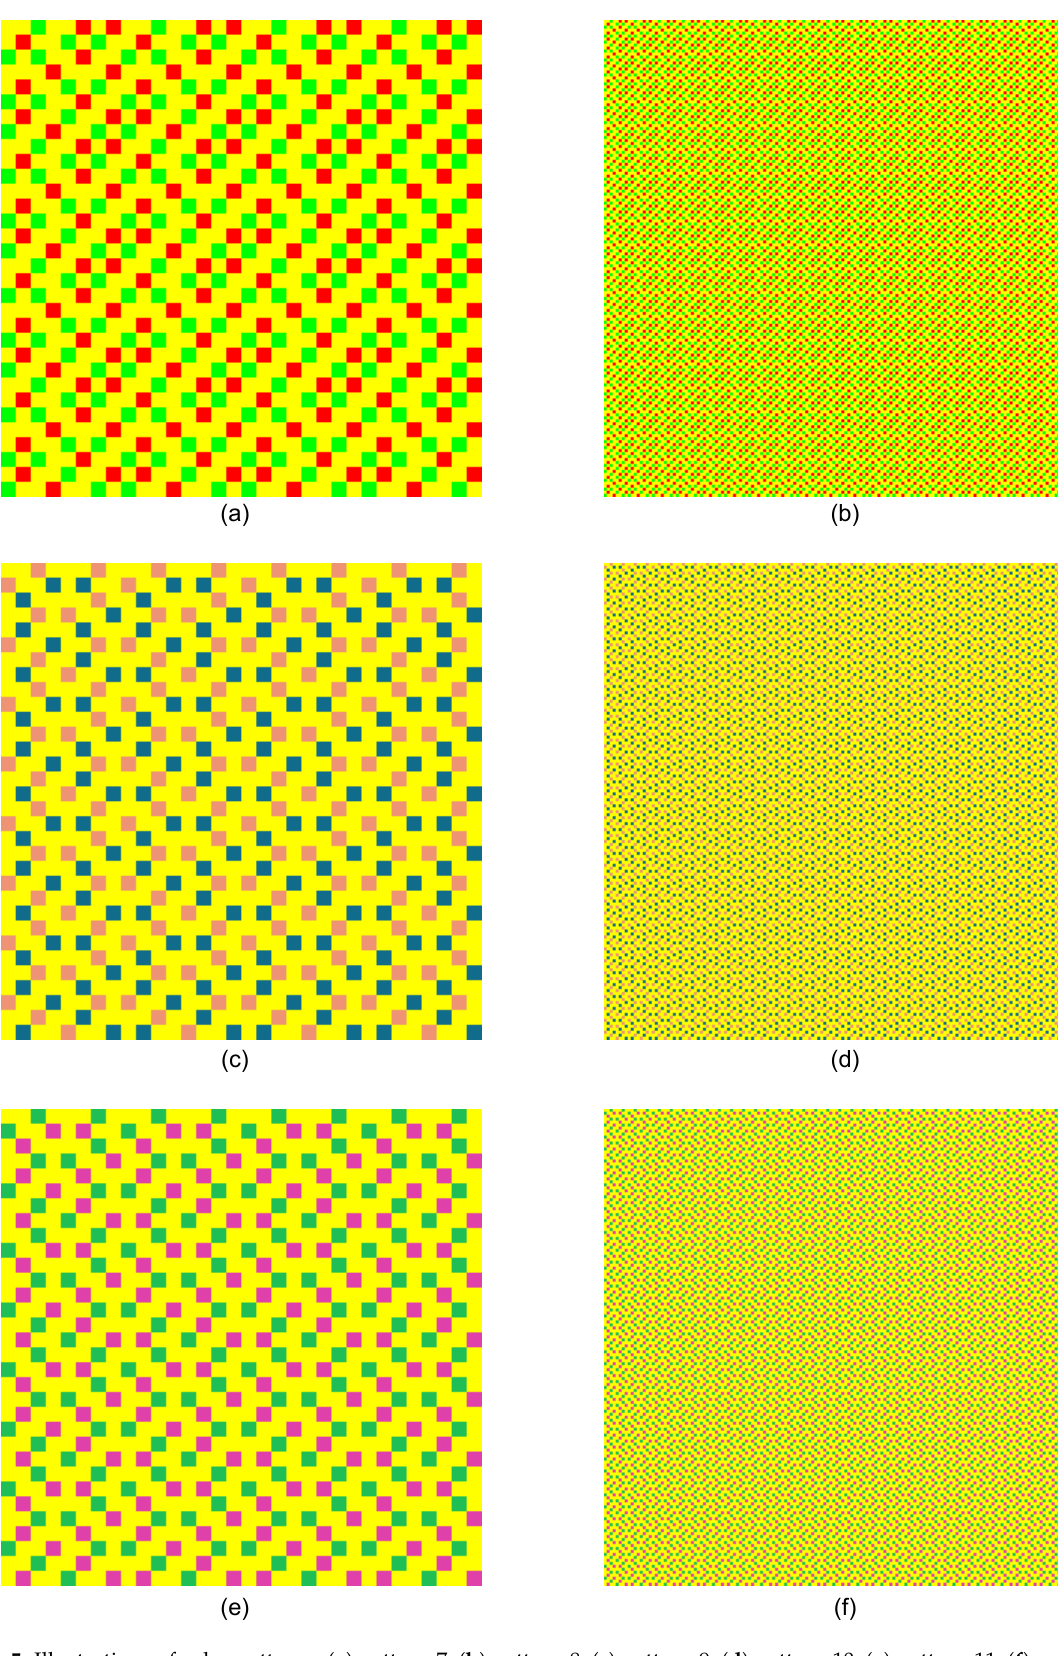
Figure 5. Illustrations of color patterns: ( a ) pattern-7 , ( b ) pattern-8 , ( c ) pattern-9 , ( d ) pattern-10 , ( e ) pattern-11 , ( f ) pattern-12.